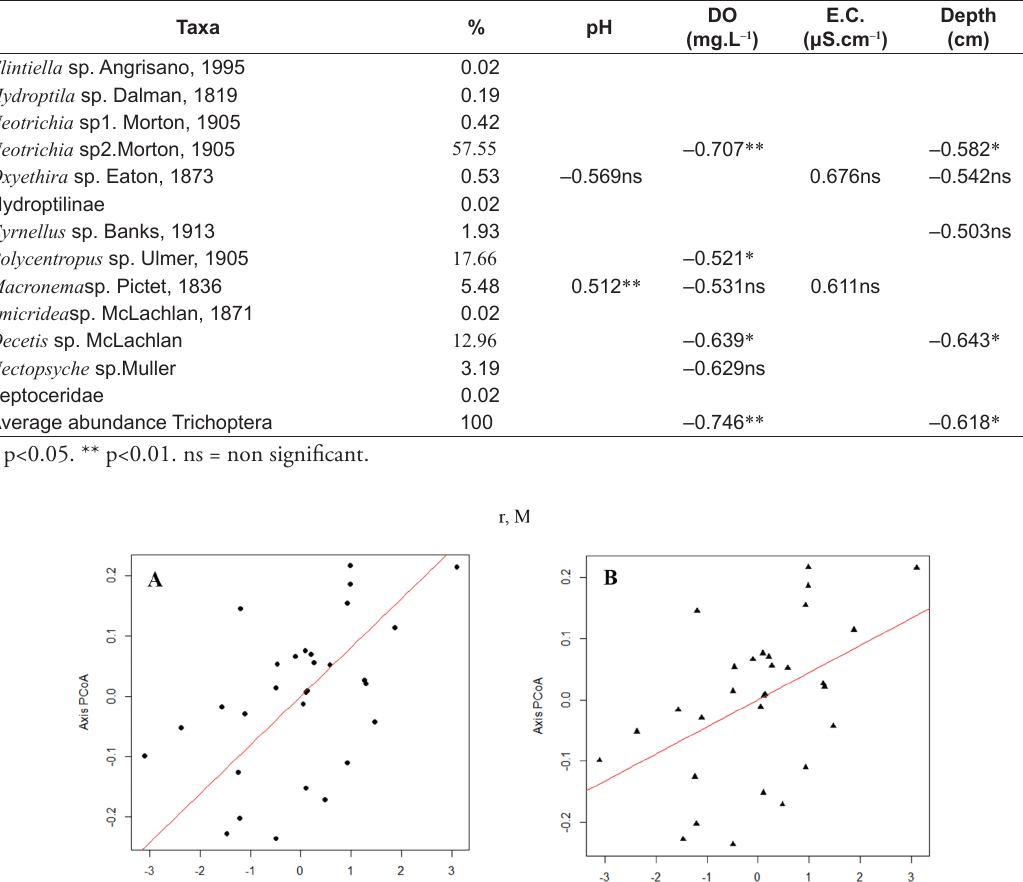
Table 2. Taxonomic composition, abundance relative (%) and Spearman correlation of genera average abundance, average abundance total of Trichoptera and of L. fortunei with physicochemical variables in the 15 marginal lakes along the Paraguay River, MT.